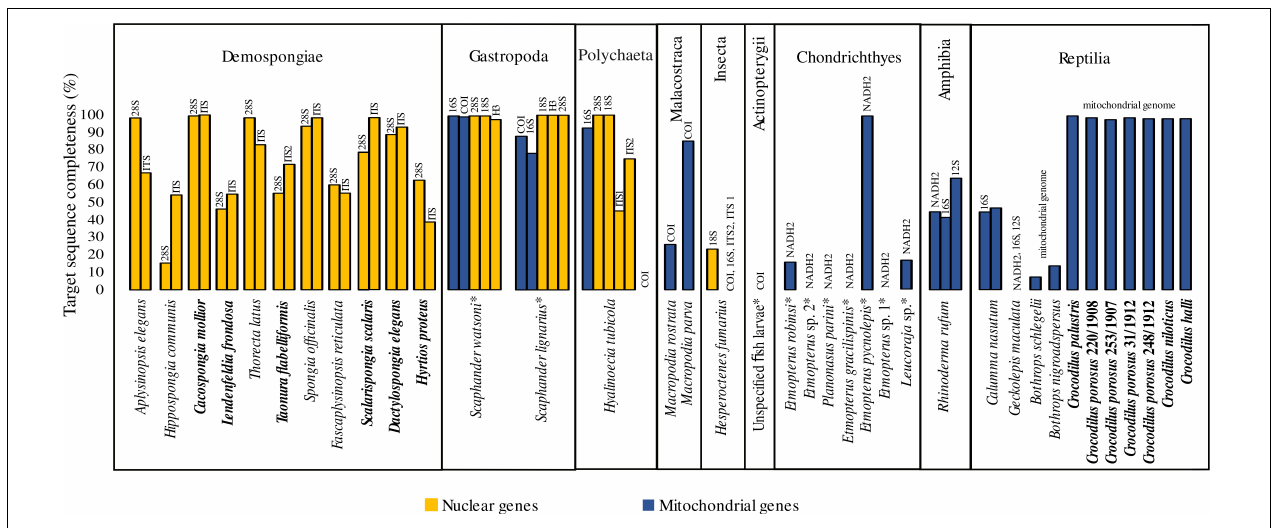
FIGURE 1 | Completeness of target genes after hybridisation capture. Dry material is indicated in bold, all other samples originate from wet-collection specimens. Assumed formalin-fixation before wet-collection preservation of specimens is indicated by an asterisk.